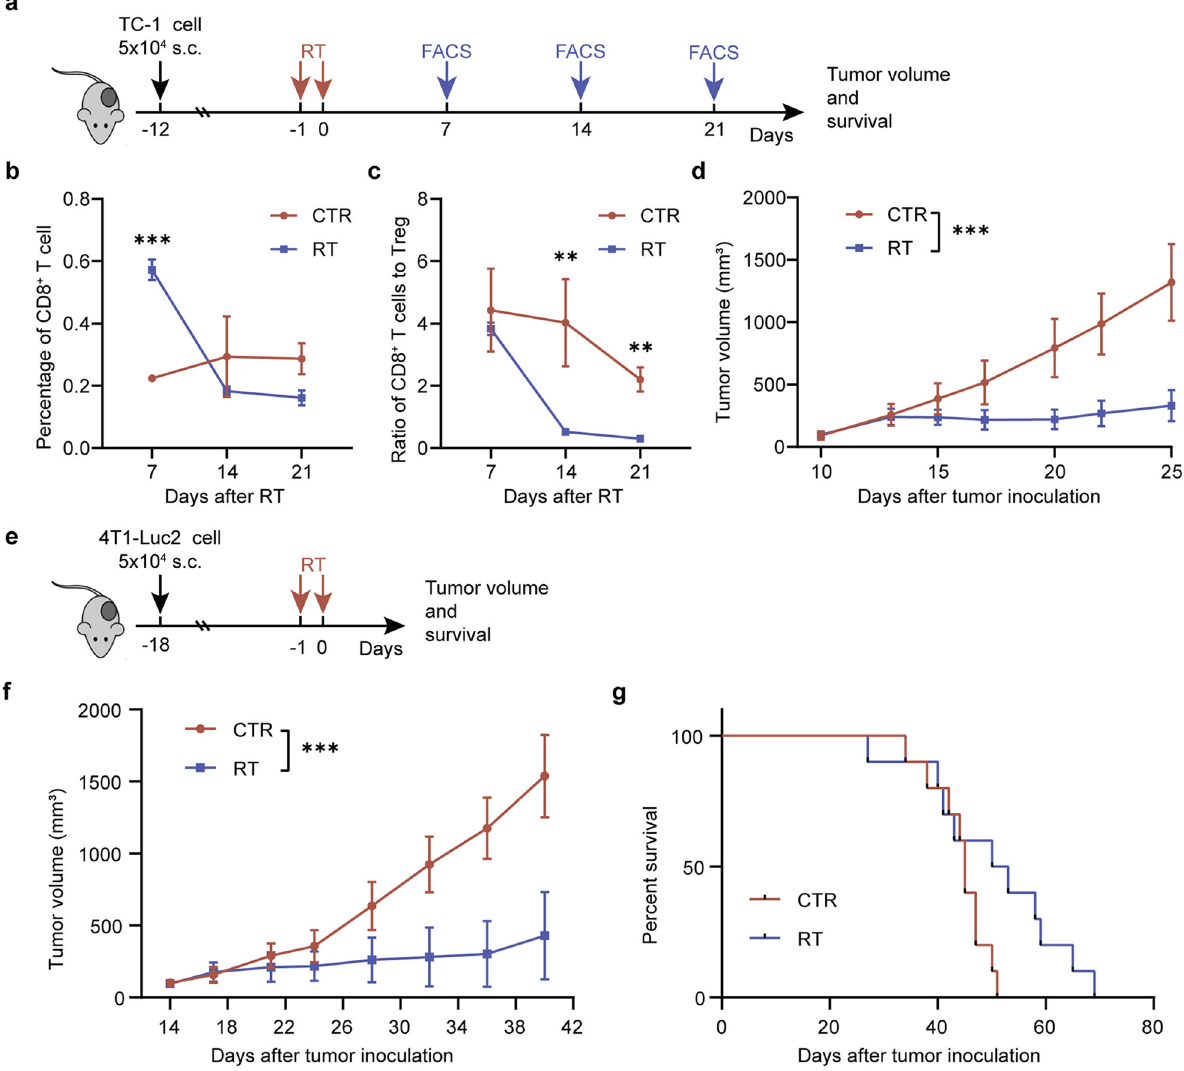
Fig. 1 Effect of radiation therapy on local tumor, and survival. a Experimental procedure of TC-1 tumor model and treatments. b , c Flow cytometry analyses ( n = 4 mice per group). Dynamic changes of CD8 + T cells ( b ) and the ratio of CD8 + T cells to Tregs ( c ) in tumors. d Tumor growth curves of mice bearing TC-1 tumors with or without RT treatments ( n = 10 mice per group). e Experimental procedure of 4T1-Luc2 tumor model and treatments. f Tumor growth curves of mice bearing 4T1-Luc2 tumors with or without radiation treatment. g Survival of mice bearing 4T1-Luc2 tumors treated with or without radiation ( n = 10 mice per group). Results are expressed as mean ± SD. Experiments were repeated two times and two-tailed t -test was used for comparisons of biological replicates. * P < 0.05, ** P < 0.01, *** P <